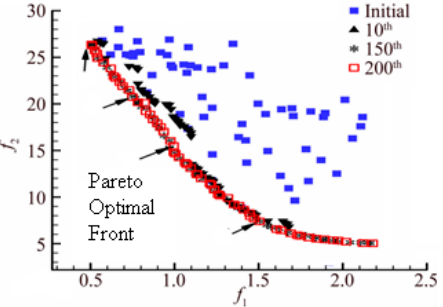
Figure 6. Distribution of Pareto optimal front.